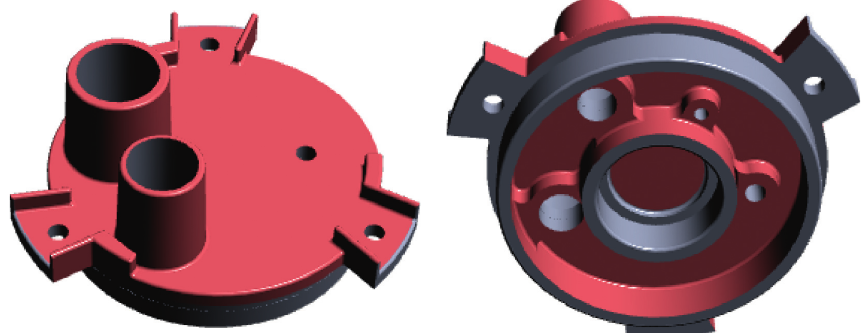
Figure 2: Case study: product selected for the study.